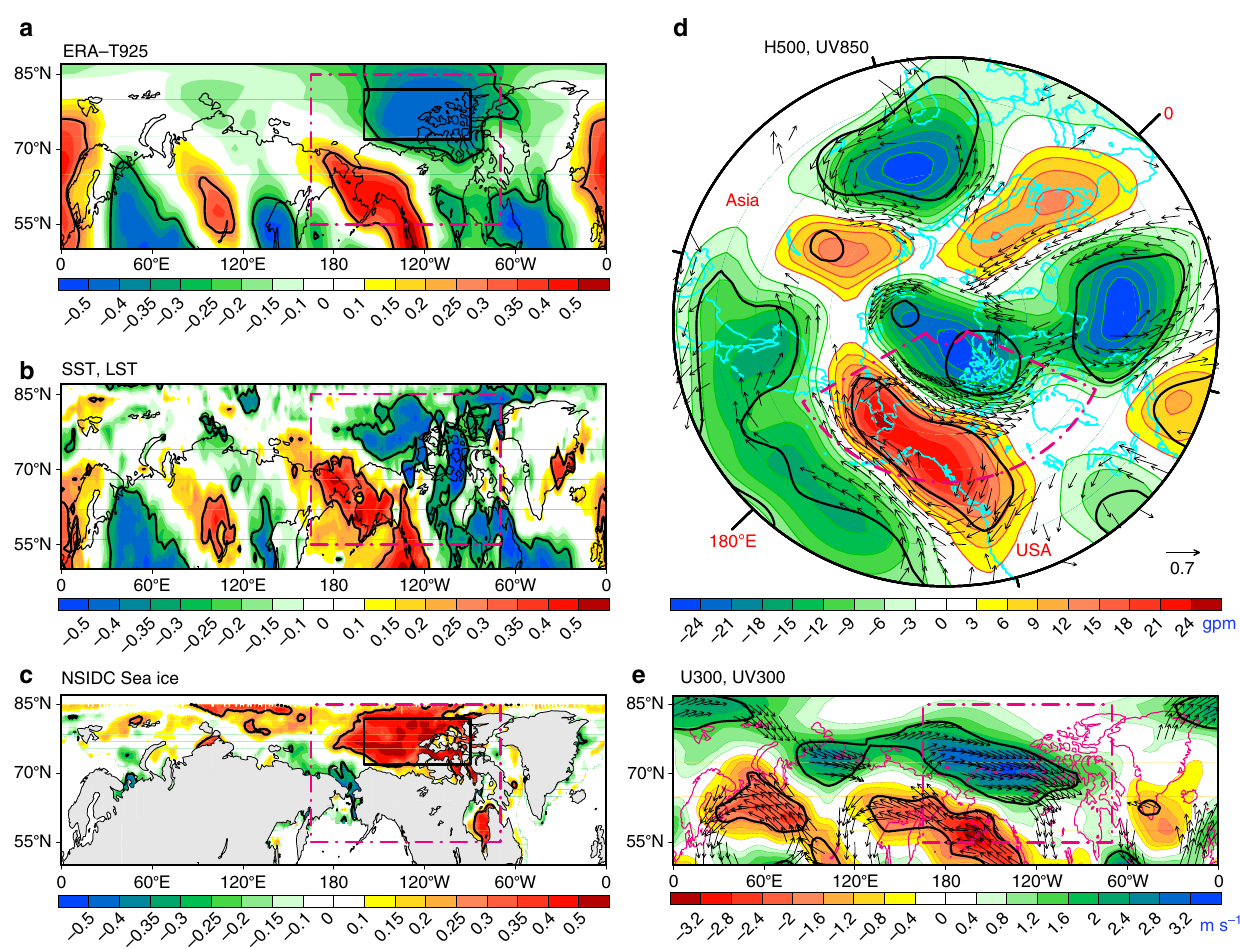
Figure 2 | Teleconnection patterns related to central Pacific SSTwarming. ( a ) Correlations of T925 with RPC2. ( b , c ) are the same as a , except for SST/ LST and SIC, respectively. Shadings in d , e denote H500 and U300 regressed, respectively, against normalized RPC2. Black arrows in d , e show the correlations (vectors less than 0.28 omitted) of UV850 and UV300 with RPC2, respectively. Thick black lines indicate correlation at the estimated 90% confidence level. Area-weighted means of T925 and SIC anomalies over the black boxes (160 (cid:2) W–90 (cid:2) W, 72 (cid:2) N–82 (cid:2) N) in a , c are used to define the T925-index and the SIC-index. The area outlined by the purple dashed box is the same in all five panels. Here, the atmospheric data sets are from the ERA-Interim